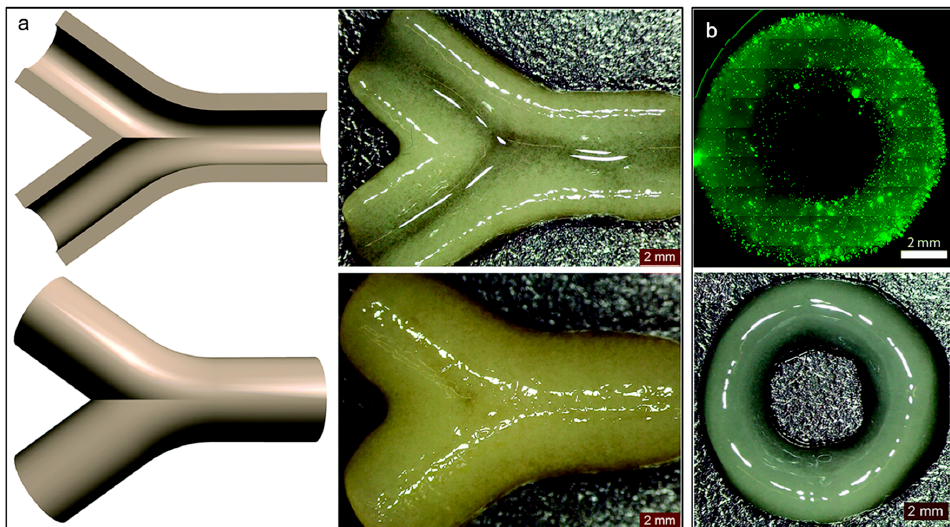
Figure 11. Bifurcation vascular tubes and cell-laden hydrogel rings bioprinted using stereolithography ( a ) CAD models of bifurcation vascular tubes (left) and the resulting hydrogel vessels visualized by their cross-section and top view (right). ( b ) Fluorescence image (bottom) and photography (top) of a cell-laden hydrogel construct. Republished with permission of Royal Society of Chemistry, from Three-dimensional fabrication of cell-laden biodegradable poly9ethylene glycol-co-depsipeptide) hydrogels by visible light stereolithography, Elomaa et al. Vol. 3, Issue 42. Copyright (2015), permission conveyed through Copyright Clearance Center, Inc. [56].